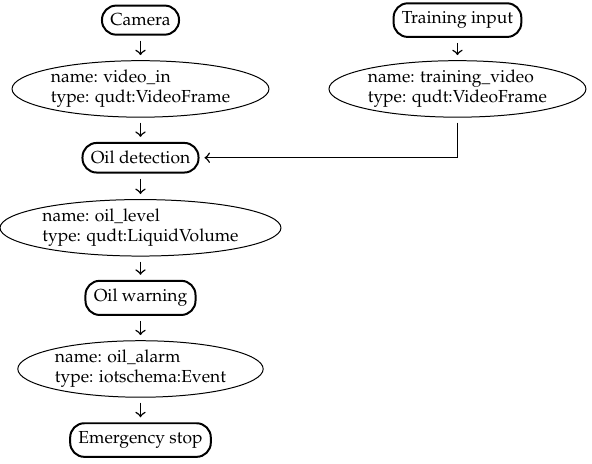
Figure 2. A simple oil leak detector